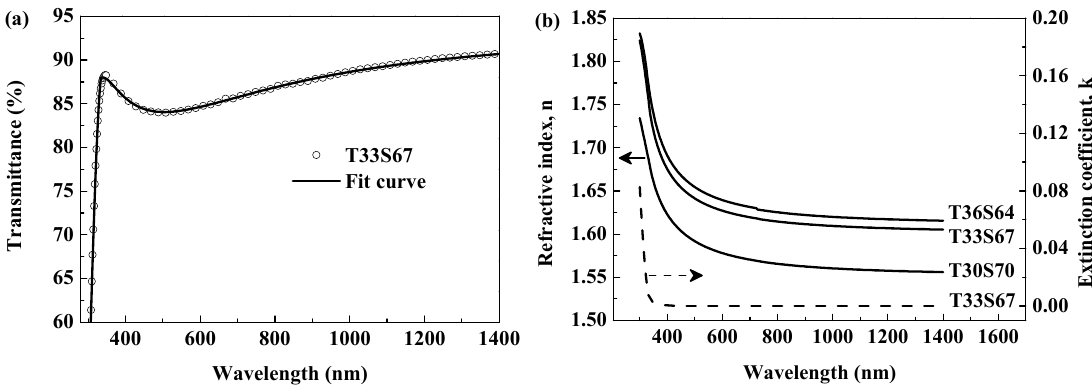
Figure 6. ( a ) Representative fitting using the Cody–Lorentz model for film T33S67; ( b ) dispersion curves of refractive index and extinction coefficient of the TiO 2 –SiO 2 hybrid films.